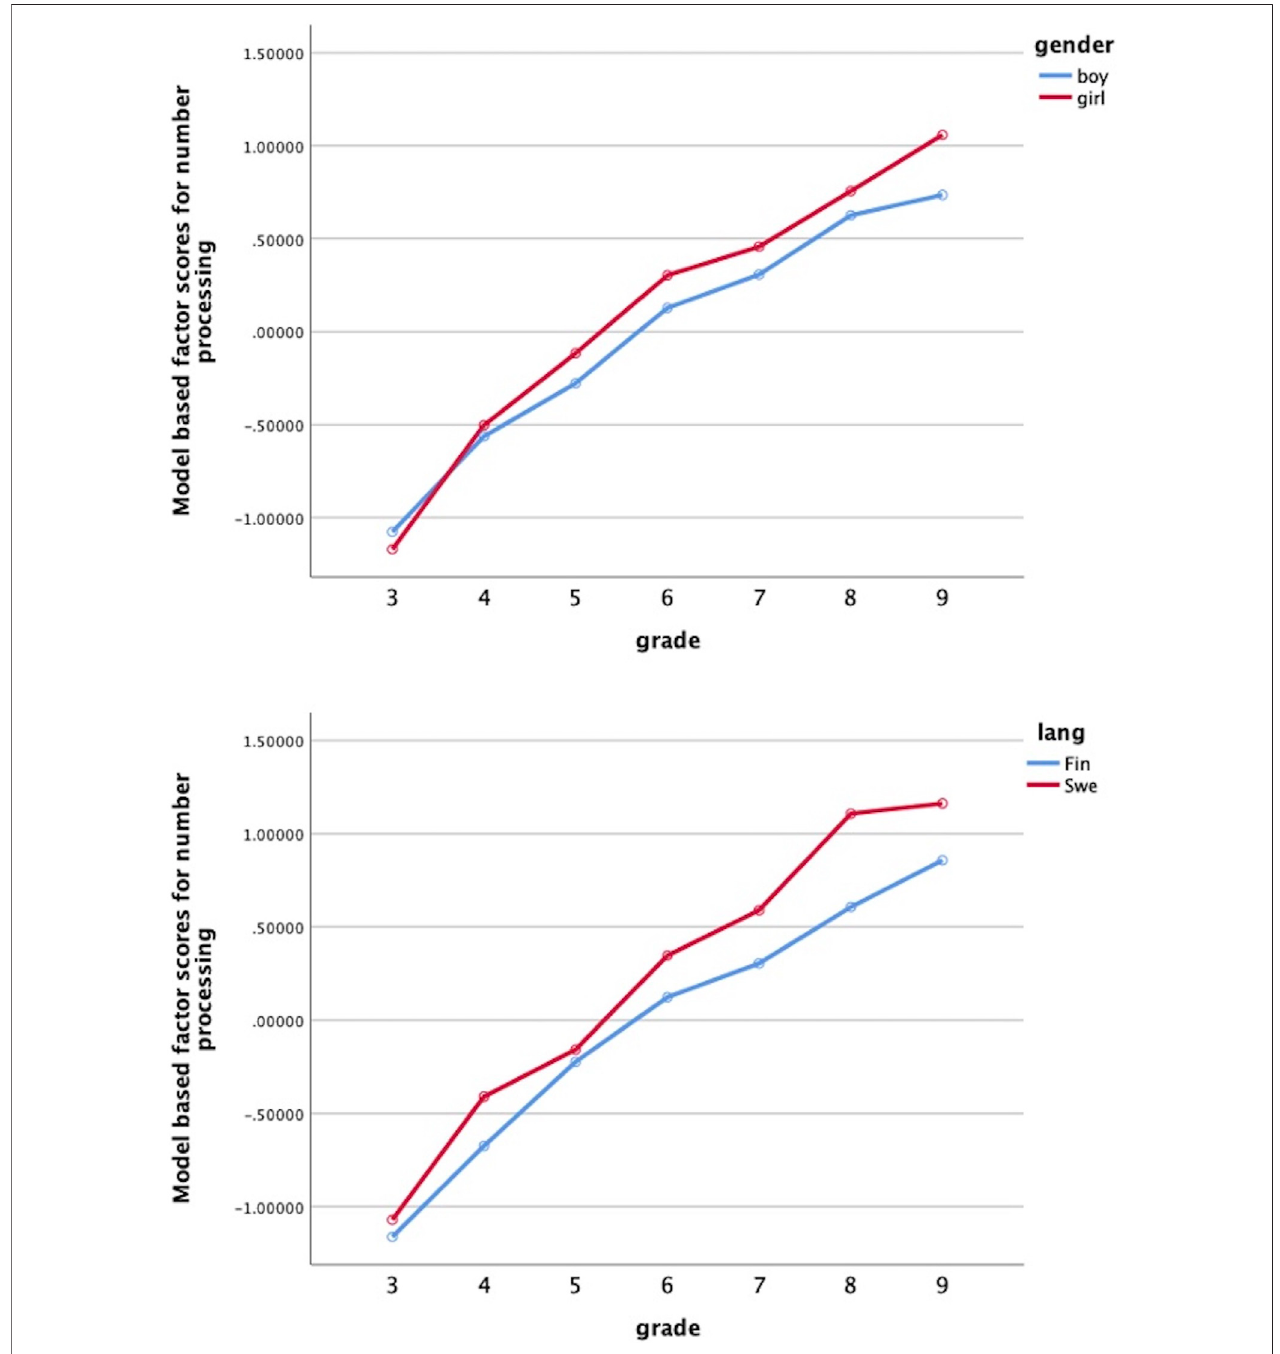
FIGURE 3 | (A) The two-way interaction between gender and grade level on number processing. lang (cid:1) language group, (B) The two-way interaction between language group and grade level on number processing. Note. lang (cid:1) language group; Fin (cid:1) Finnish-speaking students; Swe (cid:1) Swedish-speaking